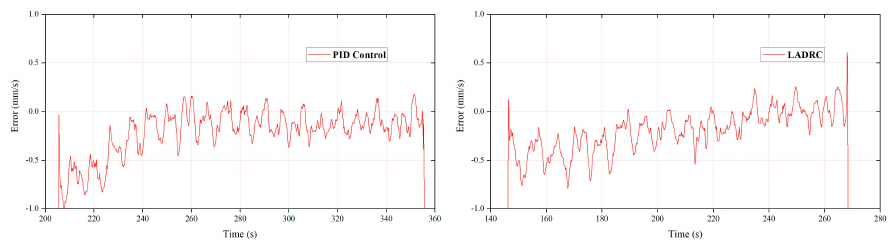
Figure 28. Speed error of cylinder #4 during folding.